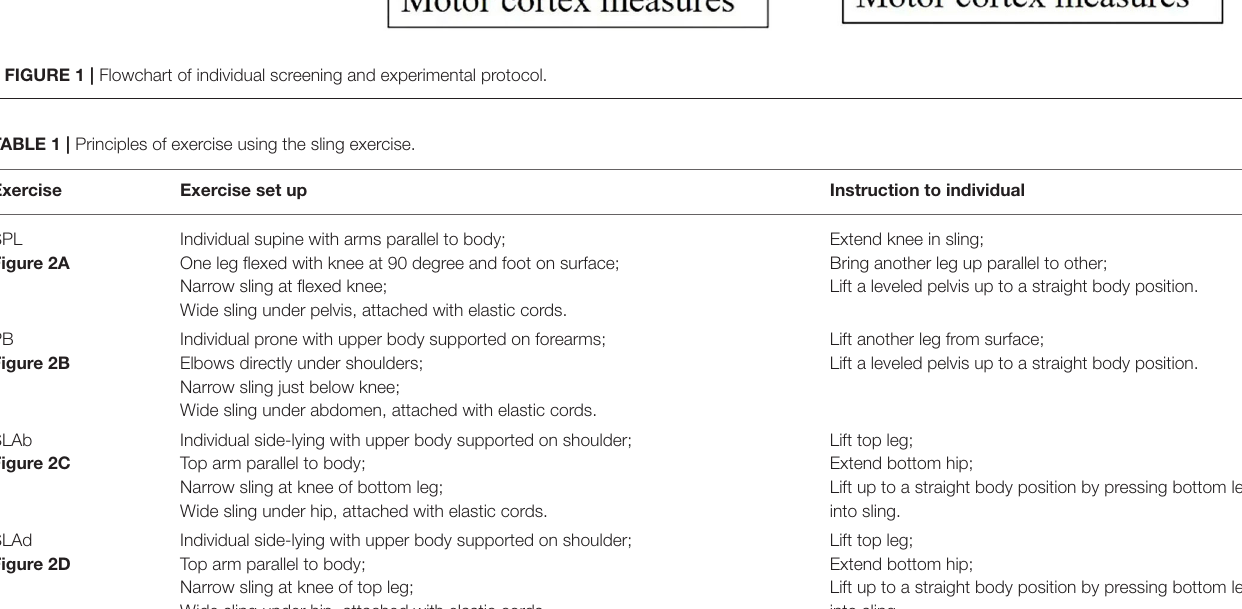
Lift top leg; Extend bottom hip; Lift up to a straight body position by pressing bottom leg into sling.